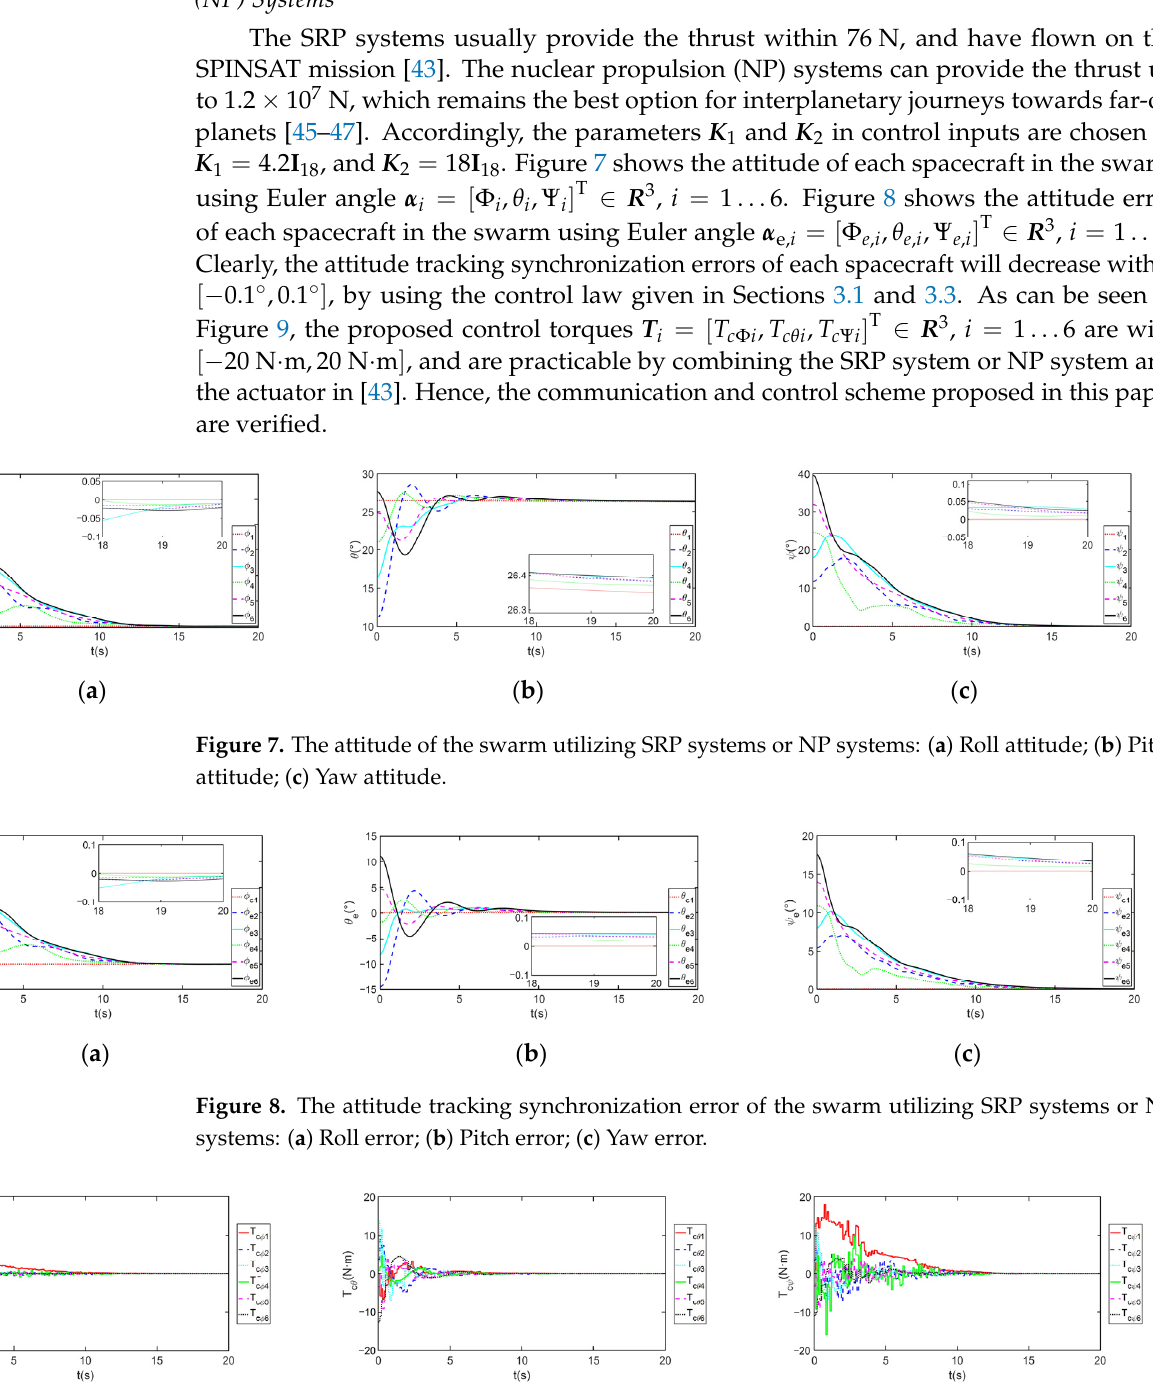
Figure 6. The control torque for the swarm utilizing LP systems: ( a ) Roll torque; ( b ) Pitch torque; ( c ) Yaw torque.